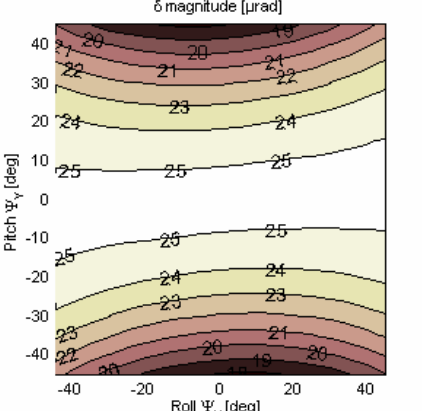
Figure 3 Magnitude of aberration vs roll and pitch